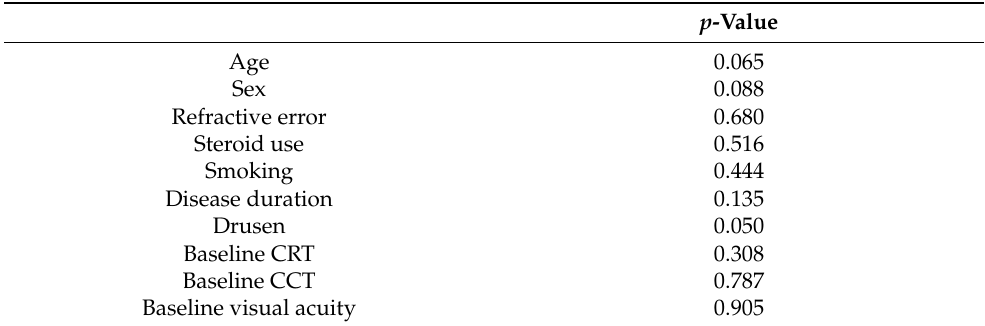
Table 3. Univariate analysis for factors of additional